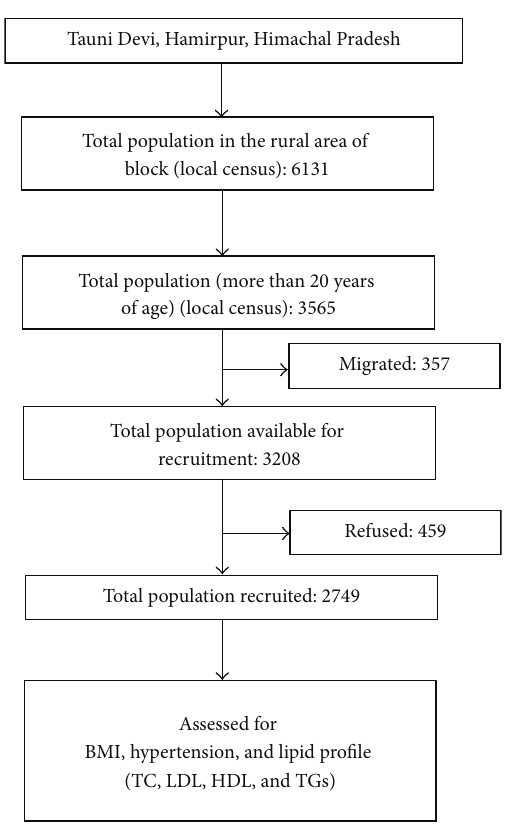
Figure 1: Recruitment of rural cohort in sub-Himalayan region of